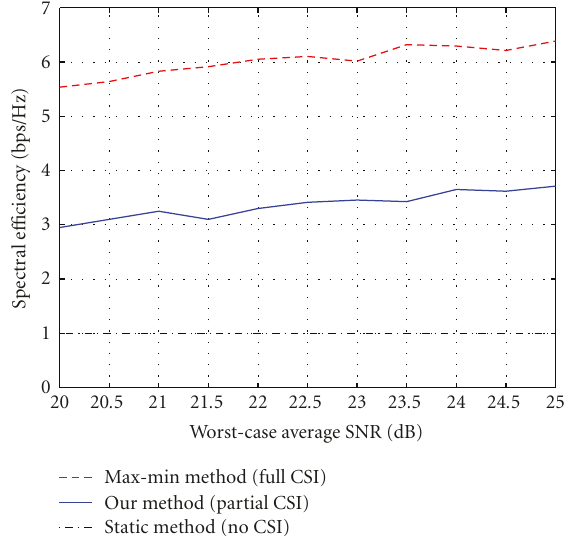
Figure 12: Average spectral e ffi ciency of our allocation method compared to the static and max-min methods for U = 100 users and R cut = 120 m.